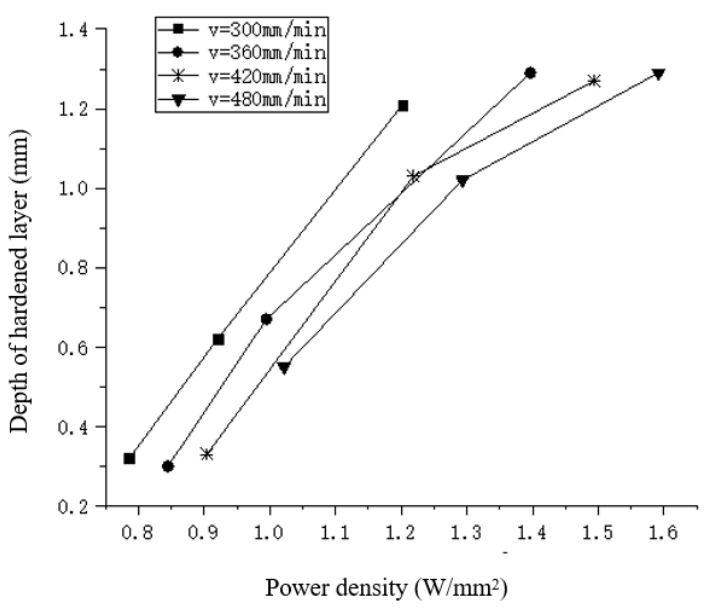
Figure 9. The relationship between different power density and hardened layer depth.